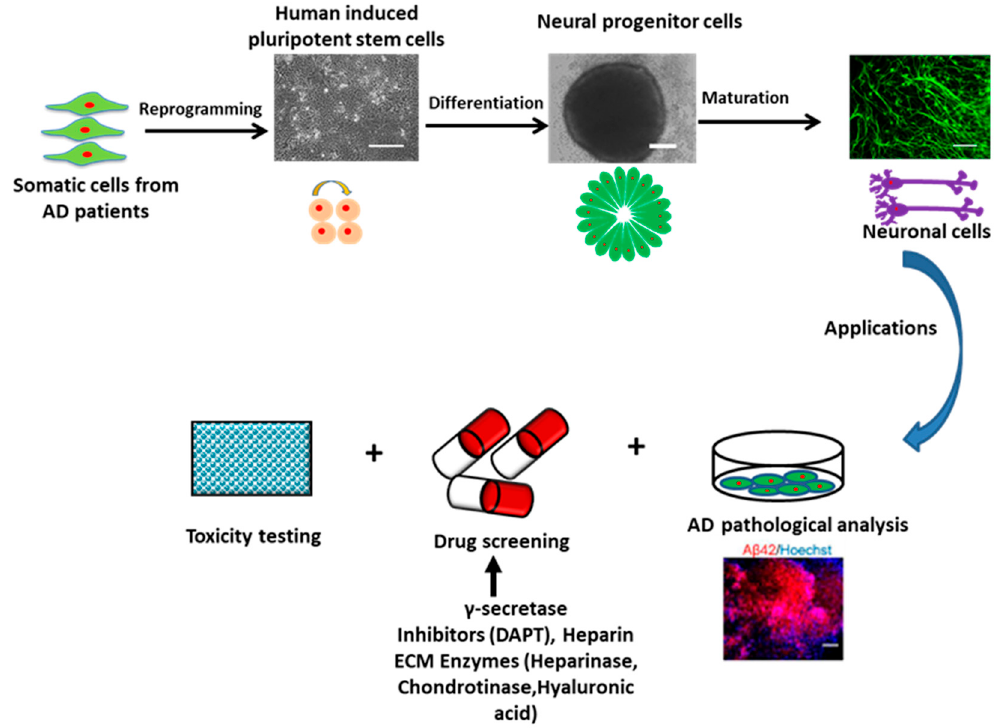
Figure 2. Schematic illustration of the process flow of using hiPSCs for AD studies. The neuronal cells derived from iPSCs cells of AD patients can be used for AD pathological analysis and various therapeutic interventions. AD: Alzheimer’s disease.